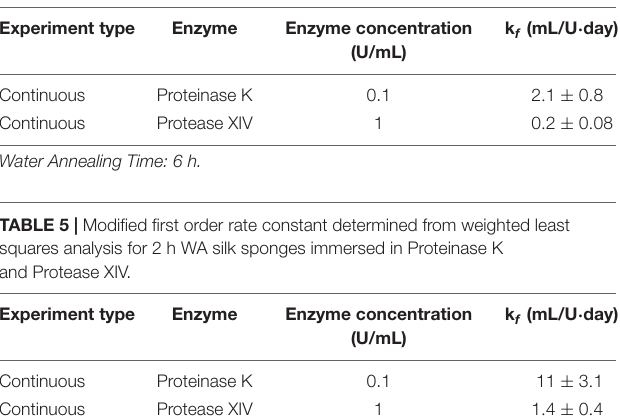
TABLE 4 | Modified first order rate constant determined from weighted least squares analysis for 6 h WA silk sponges immersed in Proteinase K and Protease XIV.